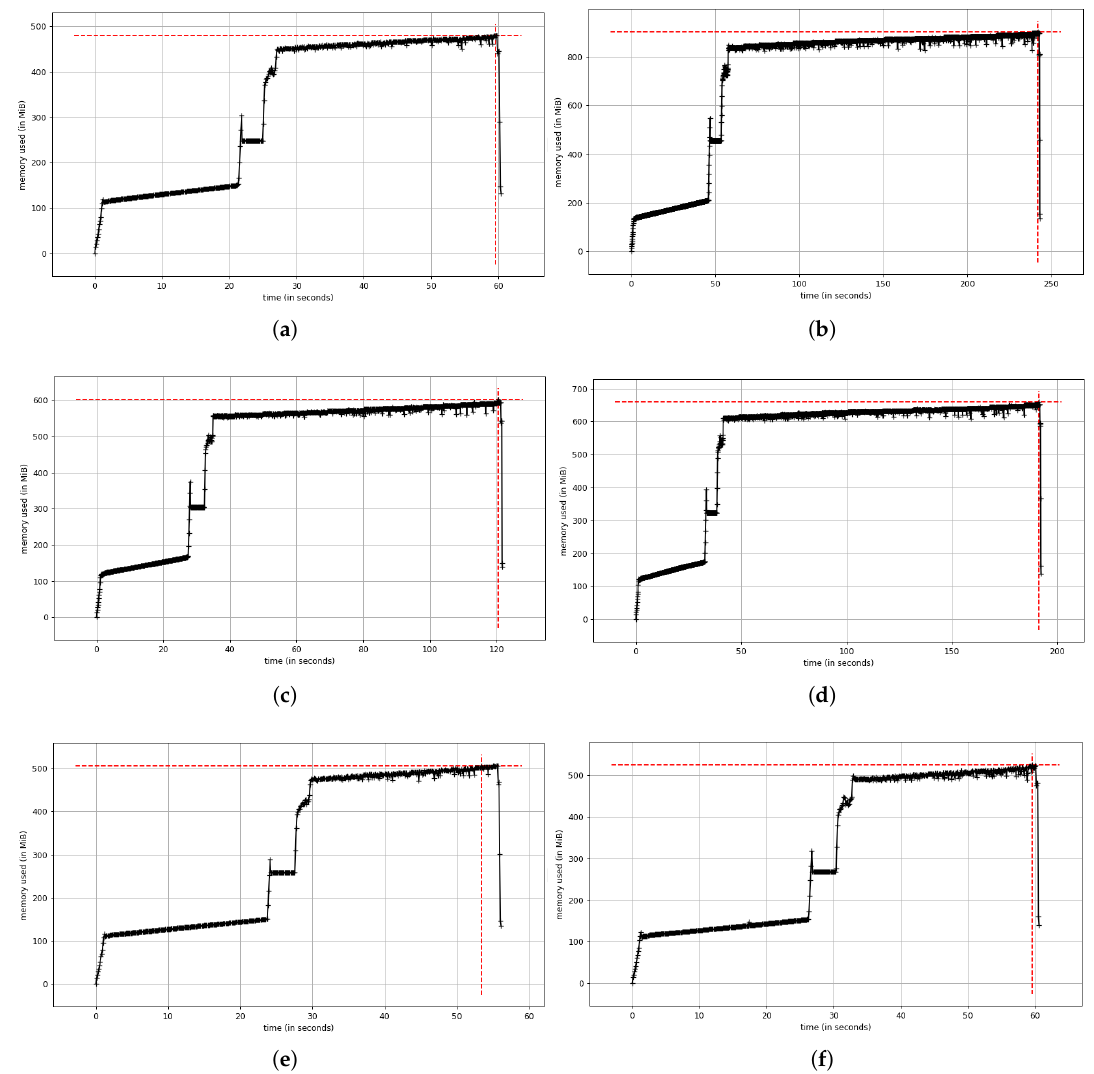
Figure 20. Memory profile results of SFSDT model to select the best feature subset on ISCX dataset. ( a ) Saturday data; ( b ) Sunday data; ( c ) Monday data; ( d ) Tuesday data; ( e ) Wednesday data; ( f ) Thursday data.